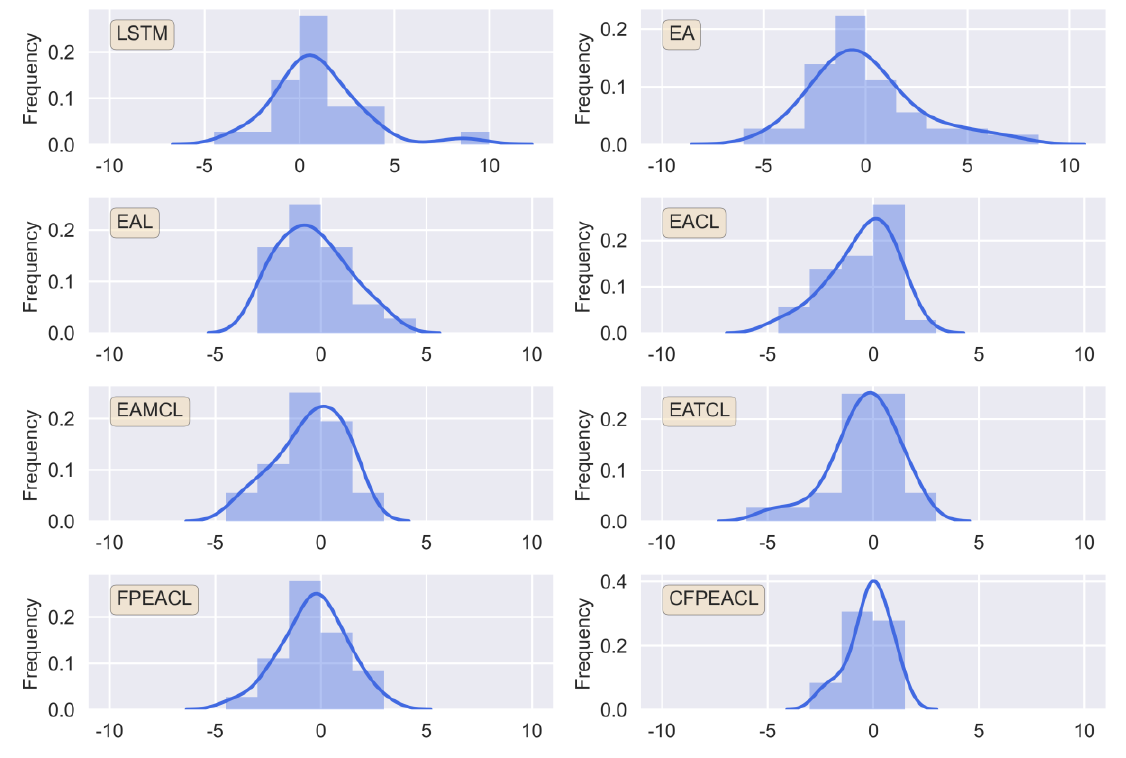
Figure 11. The histogram of error frequency for each model.